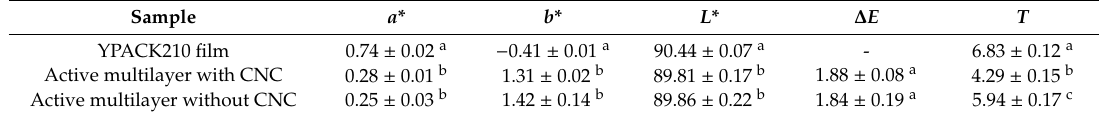
Table 1. Color parameters and transparency value of the neat YAPCK210 film and active multilayer films with and without cellulose nanocrystal (CNC) coatings.